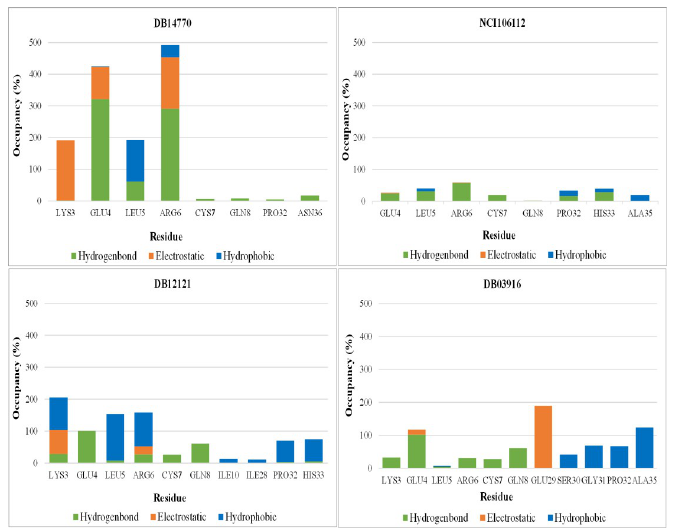
Fig 8. The interactions occupancy between ligands and the residues of